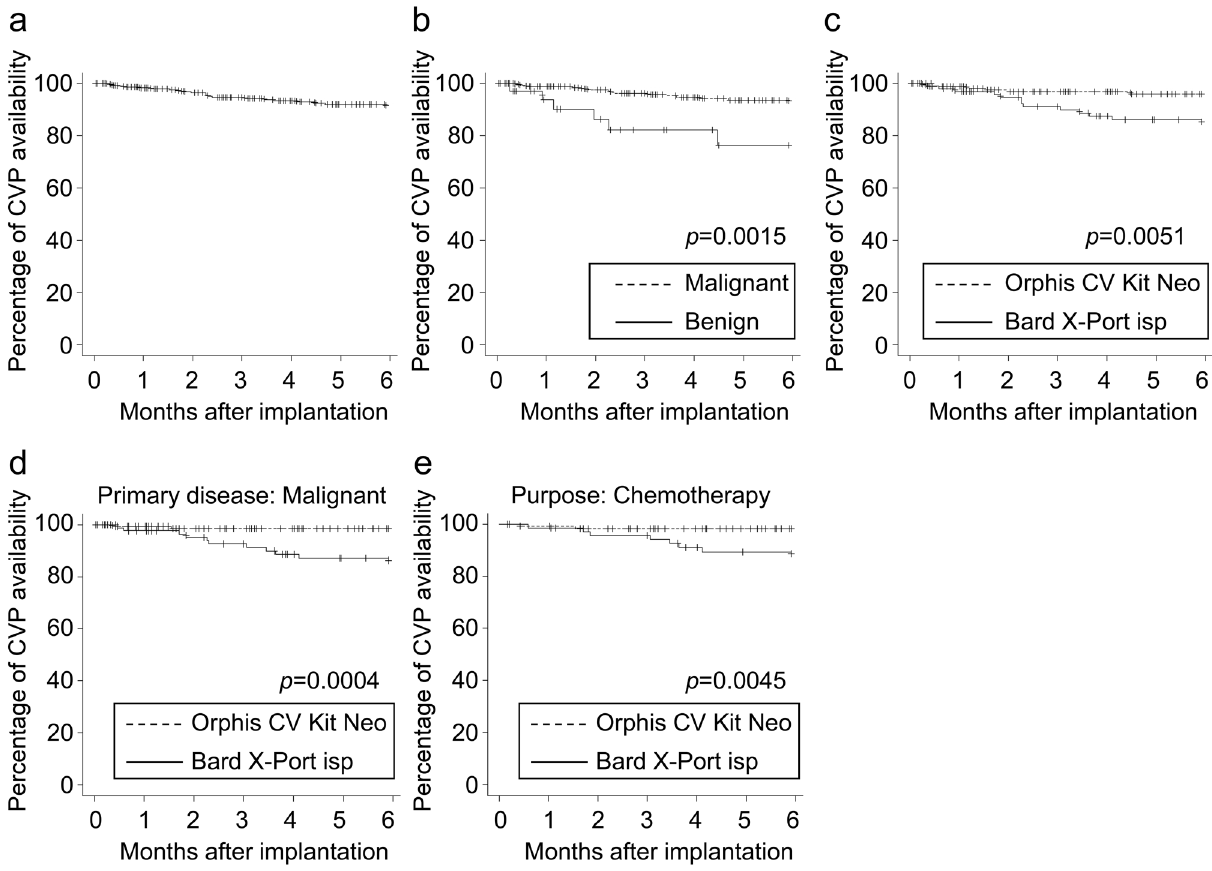
Figure 1. Kaplan–Meier curves showing central venous port (CVP) availability in ( a ) all patients, ( b ) patients with malignant or benign disease, and ( c ) patients with Orphis CV Kit Neo or Bard X-Port isp. Kaplan–Meier curves showing CVP availability in ( d ) patients with malignancies or ( e ) patients implanted for chemotherapy. Significance determined by the log-rank test is shown.